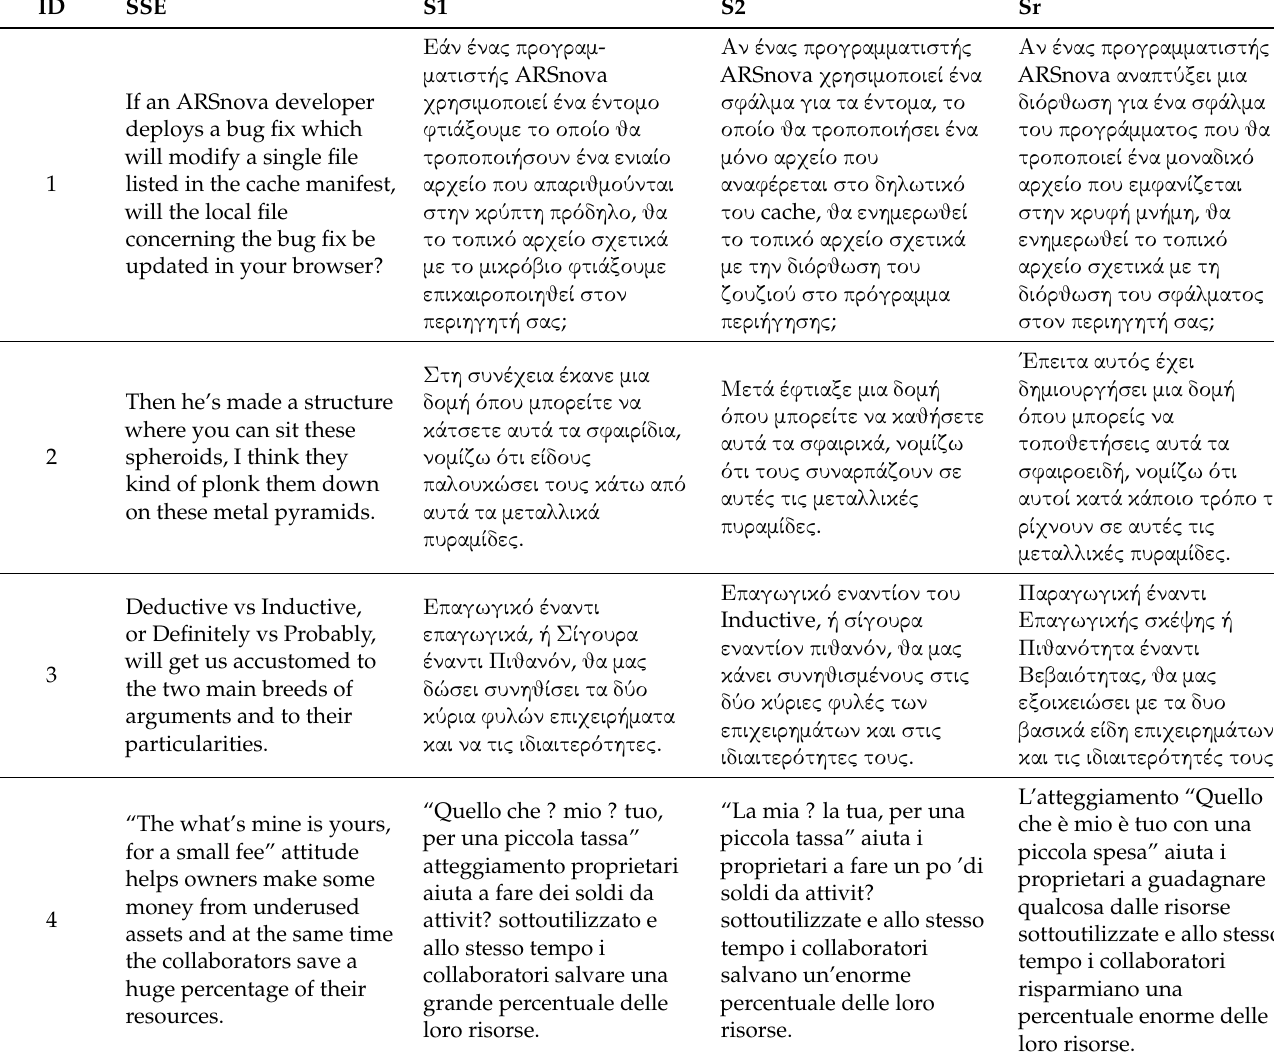
Table 5. Linguistic Analysis for EN-EL and